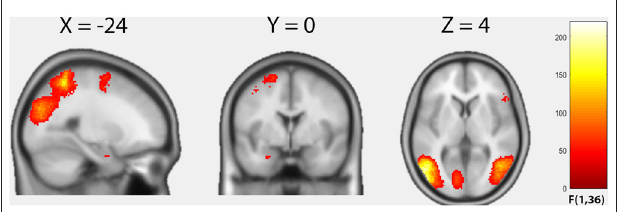
FIGURE 1 | Results of the factorial analysis. Average effect of condition ( F -contrast) “harmful movements > neutral movements”. Statistical maps are thresholded with p < 0.05, voxel-level family-wise error correction